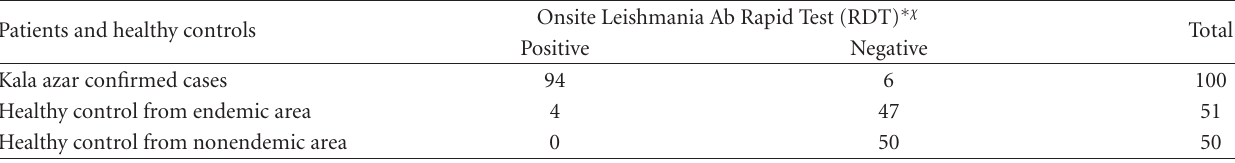
Table 1: Sensitivity and specificity of “Onsite Leishmania Ab Rapid Test” strips for diagnosis of VL in Bangladesh. Patients and healthy